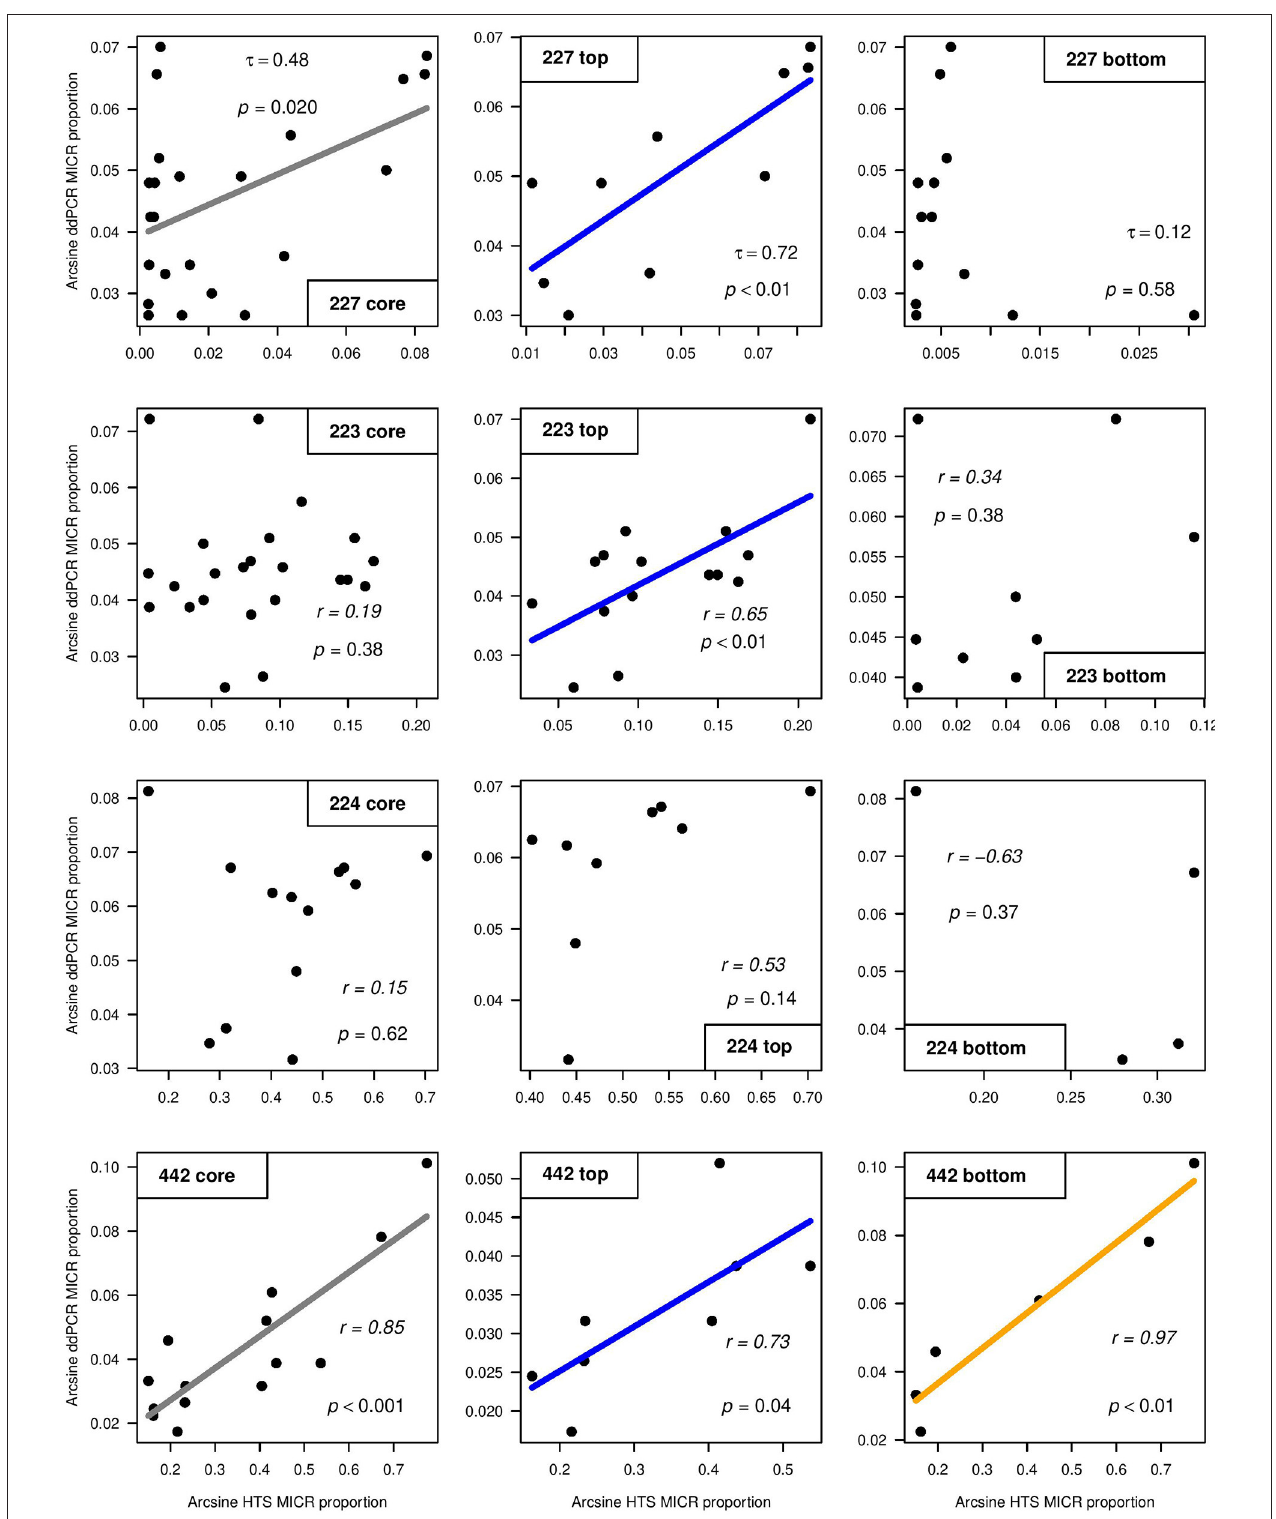
FIGURE 4 | Correlations between arcsine square root transformed droplet digital PCR (ddPCR) and high-throughput sequencing (HTS) (using SILVA) relative abundance outputs for Microcystis (MICR) across the whole core (left), top sediments (middle), and bottom sediments (right) of study lakes 227, 223, 224, and 442. Kendall’s τ (Lake 227) and Pearson’s r (lakes 223, 224, and 442) correlation coefficient values are shown.